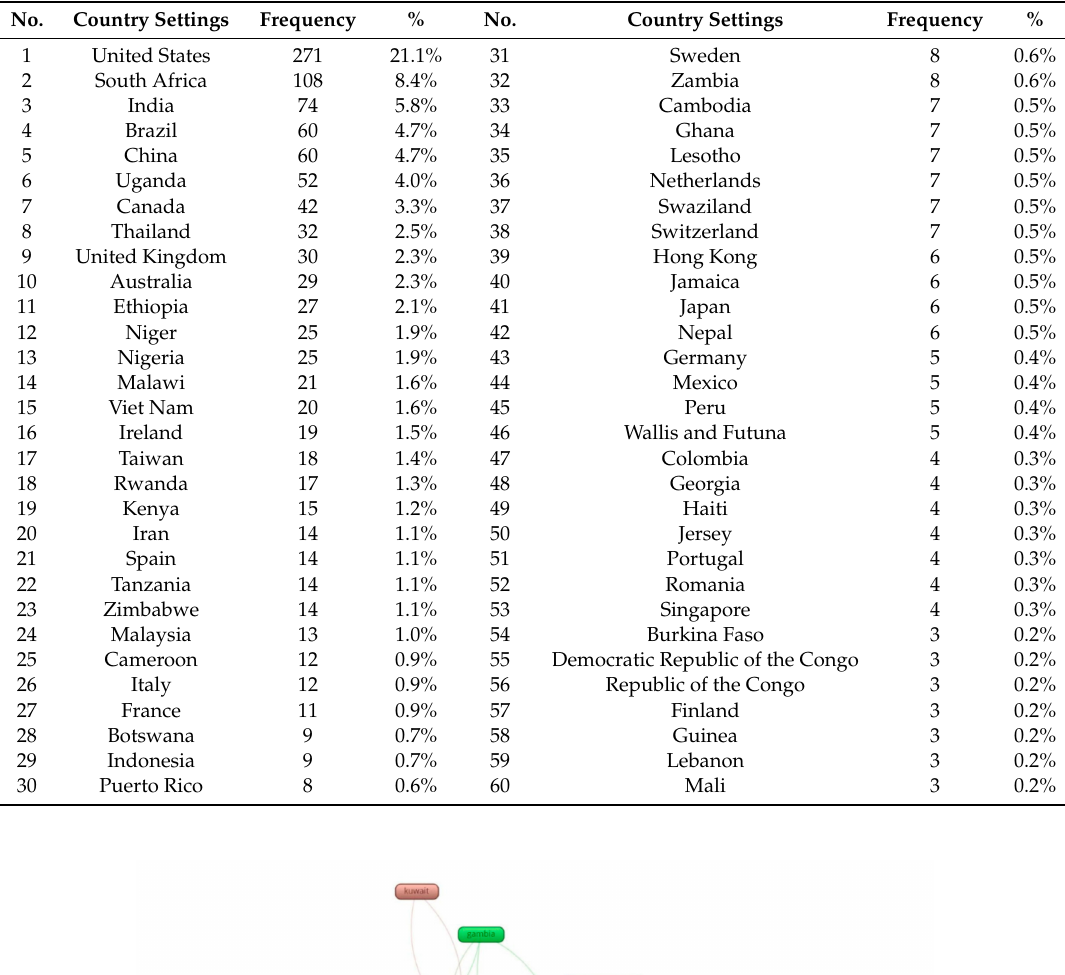
Table 2. A number of papers by countries as study settings.